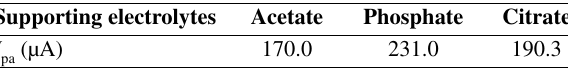
Supporting electrolytes